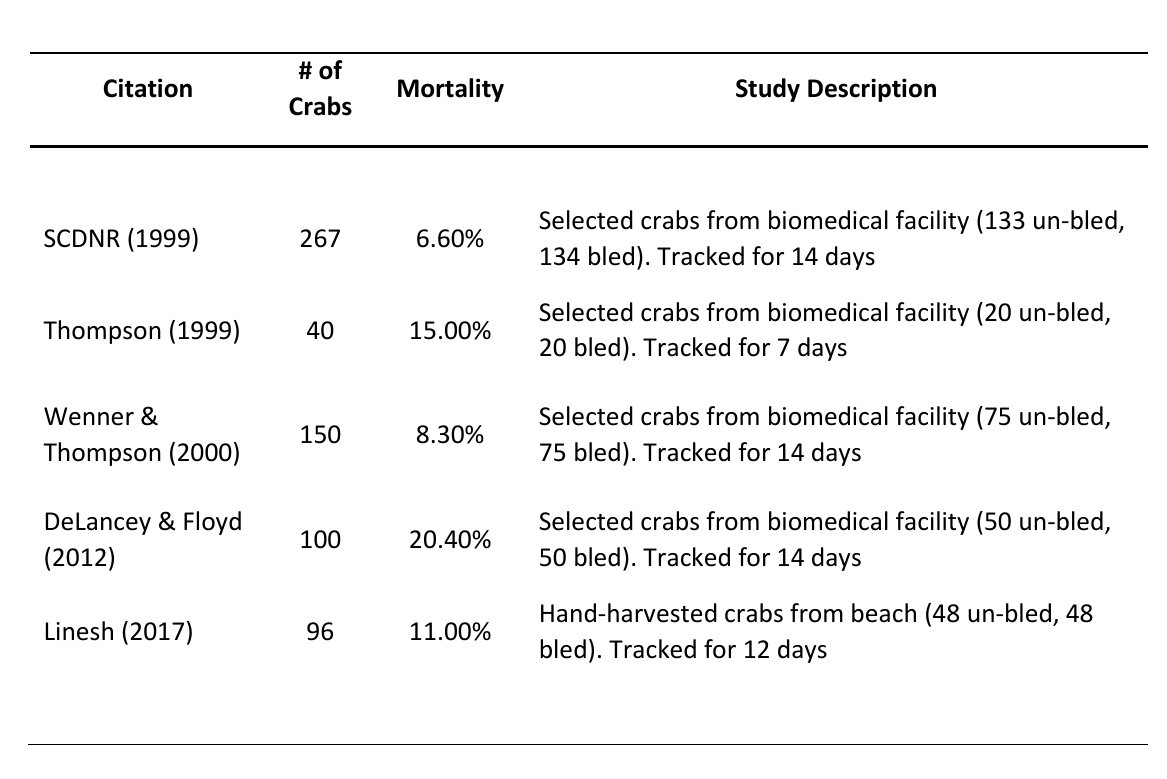
Table 1. Summary of biomedically-related mortality assessments conducted in